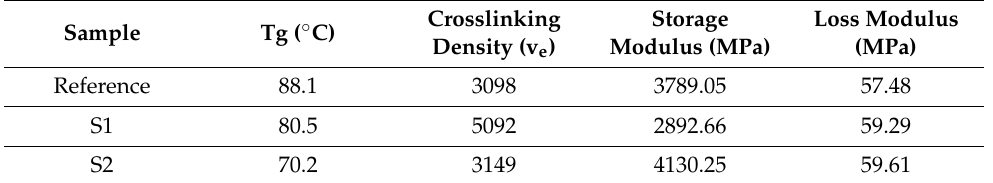
Figure 3. DMA analysis of ( a ) PUF-DCPD, ( b ) MUF-ENB self-healing systems and ( c ) neat epoxy matrix. Table 5. Crosslink density for the two self-healing